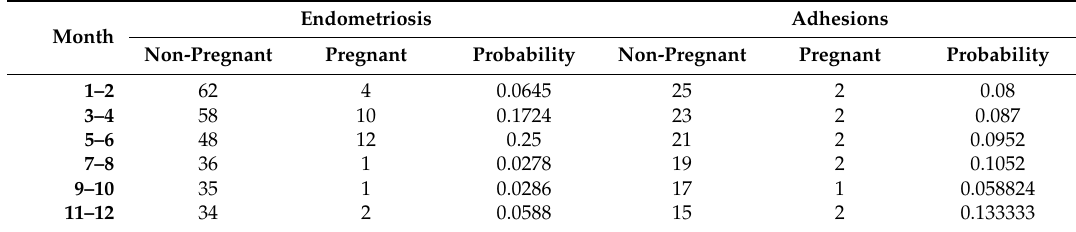
Table 4. Life-Table analysis for probability of achieving a pregnancy following natural